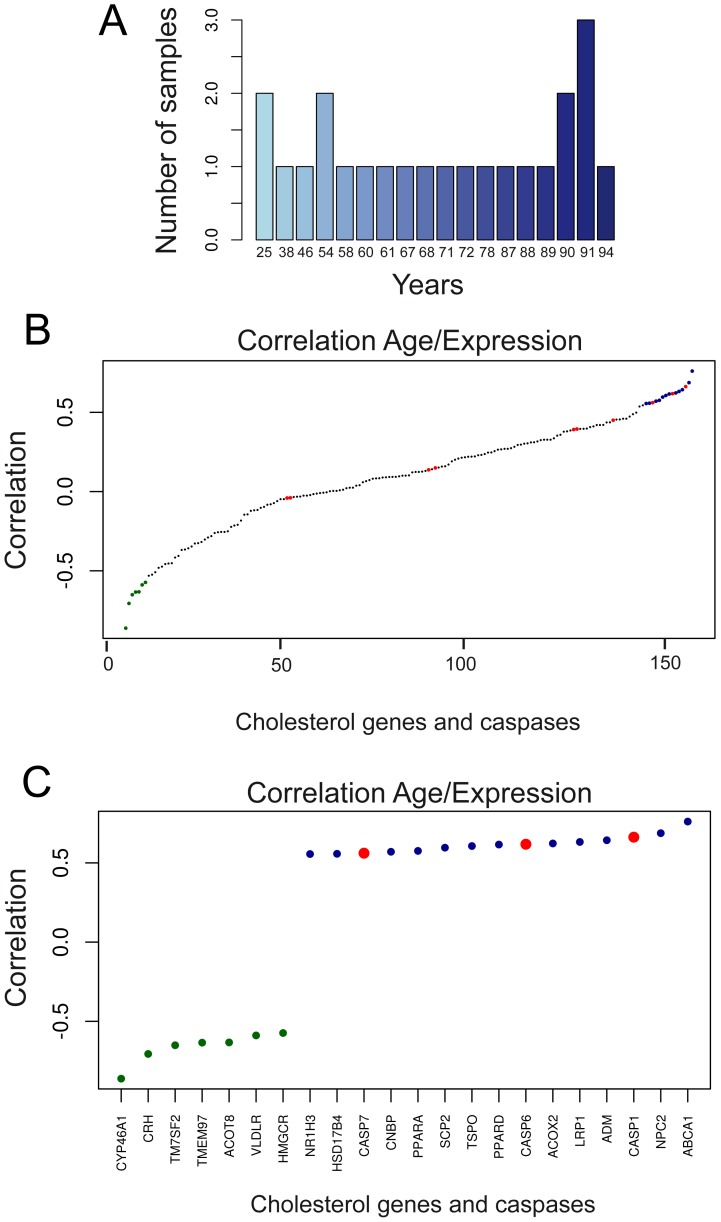
Analysis of cholesterol and caspase genes expression with aging in anterior prefrontal cortex.A. Bar plot displaying the age frequencies of the samples used in the analysis. B. Dot plot of ranked correlations of the 129 genes involved in cholesterol homeostasis/steroidogenesis and caspases respect to age. C. Dot plot of ranked correlations of genes involved in cholesterol homeostasis/steroidogenesis and caspases that scored significant expression correlation with respect to age. We applied the Spearman method (Benjamini and Hockberg correction). P<0.05.